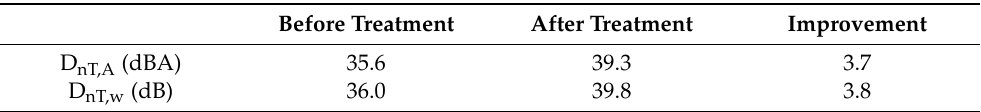
Table 11. Weighted standardized level difference values for the toilets–control room vertical partition, before and after treatment. Before Treatment